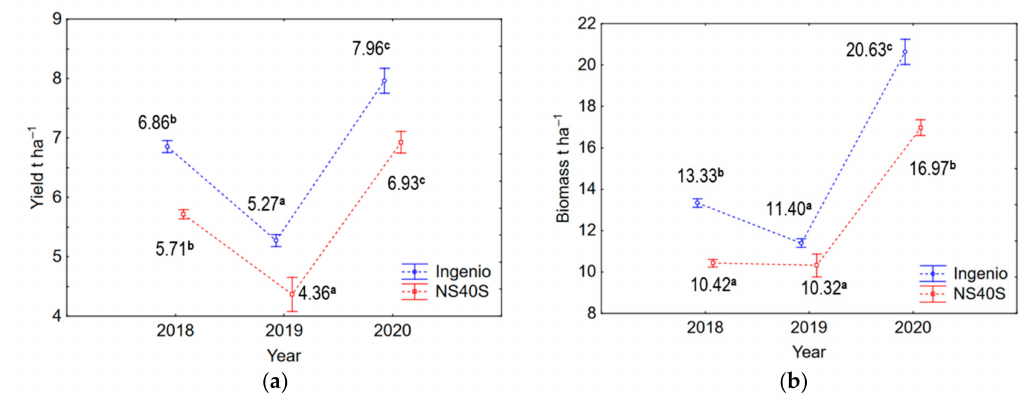
Figure 10. Effects of seasonal climate circumstances on grain yield ( a ) and biomass ( b ) of Ingenio and NS40S wheat varieties. The letters on the graph represent different classes obtained by ANOVA with p = 0.05 level of significance.